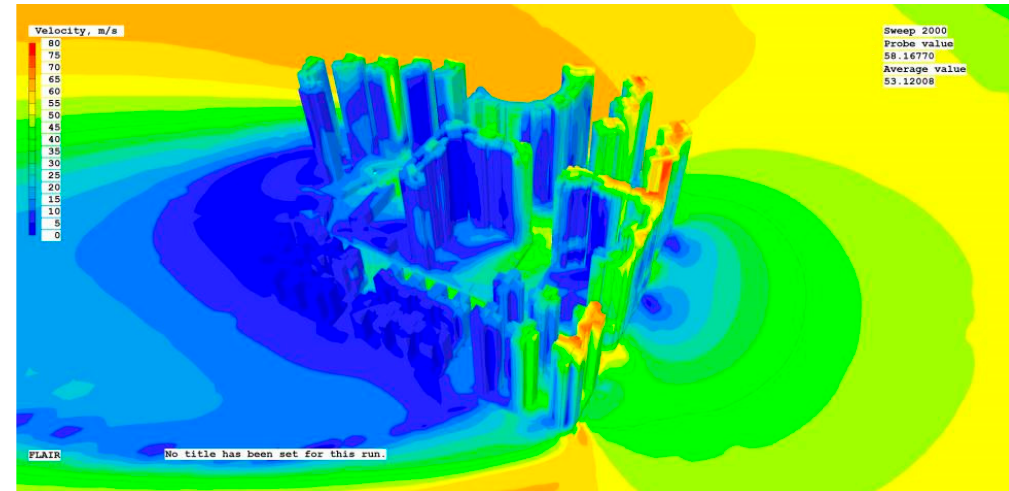
Figure A14. The EDF. Polytec Garden looks north.